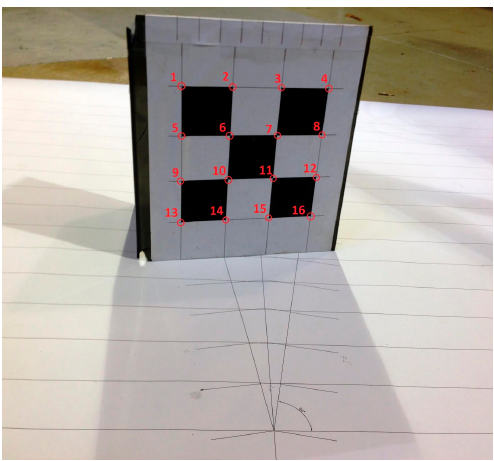
Figure 2. World coordinate system (2D x - z system plus vertical checkerboard).